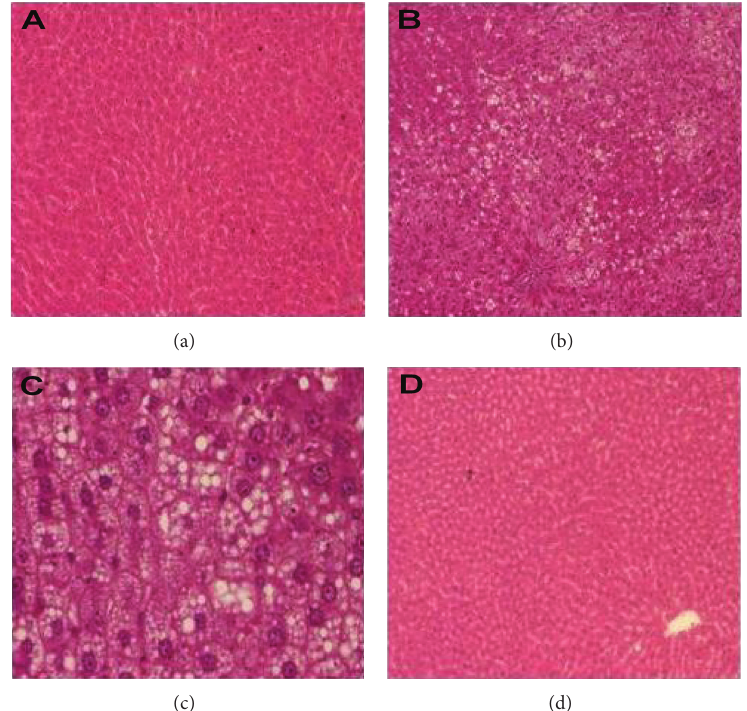
Figure 3: Histology of hepatic tissue sections dyed with haematoxylin-eosin (HE). (a) ND control (100x) showing normal structure and architecture(b)HFDfedNAFLDcontrol(100x)and(c)HFDfedNAFLDcontrol(400x)showingseveredegreeofmicroandmacrovescicular steatosis and severe hepatocellular ballooning (d) HFD fed ETS treated at 90mg/kg body weight group (100x) showing near normal structure. ETS: extract of Tamarindus indica seed coat; ND: normal diet; HFD: high fat diet; NAFLD: nonalcoholic fatty liver disease. Table 2: Effect of ETS treatment for six weeks on terminal serum and hepatic parameters in HFD-fed rat model of NAFLD. I II Parameters ND control NAFLD control